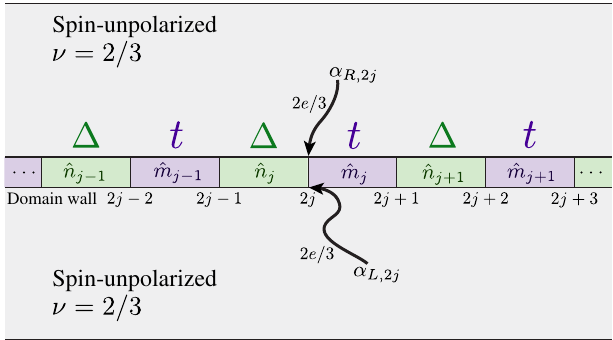
FIG. 5. Schematic of a spin-unpolarized ν ¼ 2 = 3 system hosting a trench in which the edge modes are alternately gapped by electron backscattering t and Cooper pairing Δ . The integer operators ˆ m i and ˆ n i in each domain characterize the pinning of the charge-sector fields as specified in Eqs. (44) and (45). Physically, ˆ m i − ˆ m i − 1 quantifies the total charge (top plus bottom) Q þ i on the intervening superconducting-gapped region, − ˆ n while ˆ n i i quantifies the charge difference (top minus þ 1 bottom) Q − i on the intervening tunneling-gapped segment. The remaining low-energy physics is captured by Z 3 generalizations of Majorana operators α R=L;j bound to each domain wall labeled as above. These operators cycle the values of Q (cid:3) i on the domains by adding charge 2 e= 3 (mod 2 e ) to the top and bottom trench edges, as illustrated in the figure. Charge- 2 e= 3 tunneling between neighboring domain walls hybridizes these modes and can be described by a 1D Hamiltonian [Eq. (57)] intimately related to the Hamiltonian, as in the clock-model context, is described by